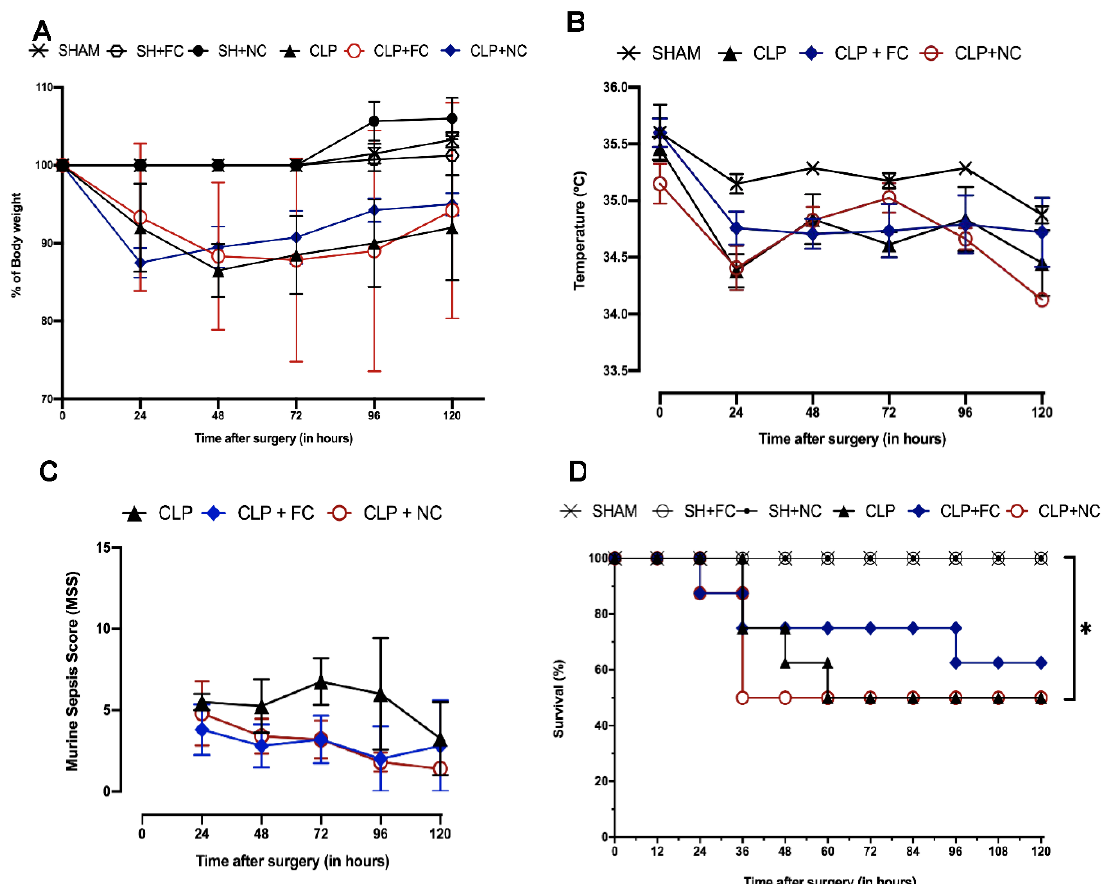
Figure 1. Characterization of murine sepsis by cecum ligation and puncture (CLP). In ( A ), find the body weight in percentage over the evaluation period. In ( B ), the temperature is observed in degrees Celsius (°C). The graph in ( C ) shows the values referring to the murine sepsis score evaluated daily. In ( D ), the data show the percentage of survival of the animals during 120 h. Animals were followed daily for 120 h after sepsis induction (n = 8 per group). p values * p < 0.05.